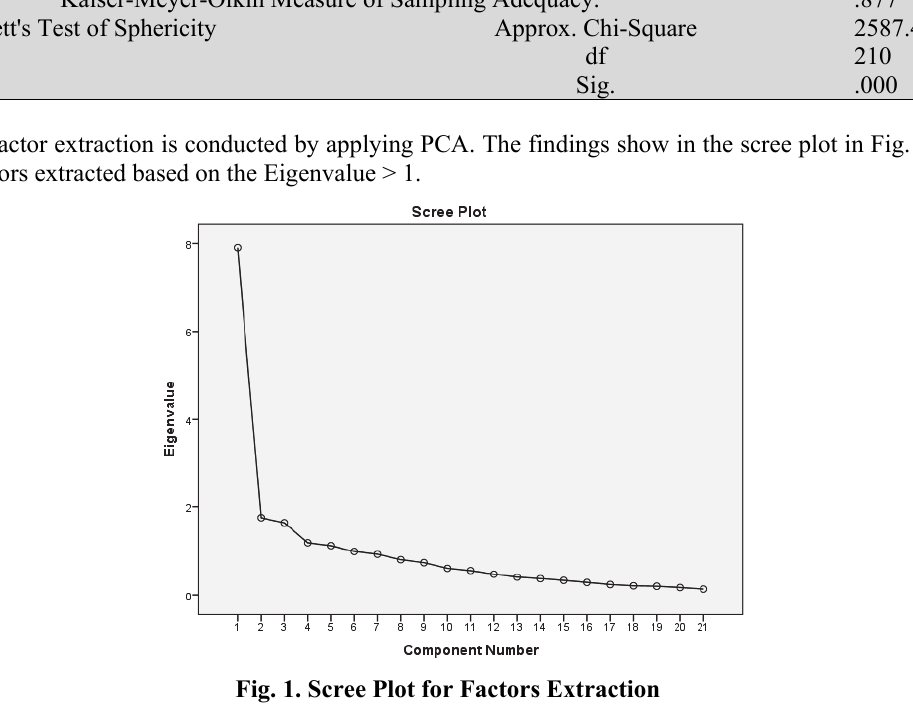
Total Variance Explained Initial Eigenvalues Extraction Sums of Squared Loadings Component Total % of Variance Cumulative %